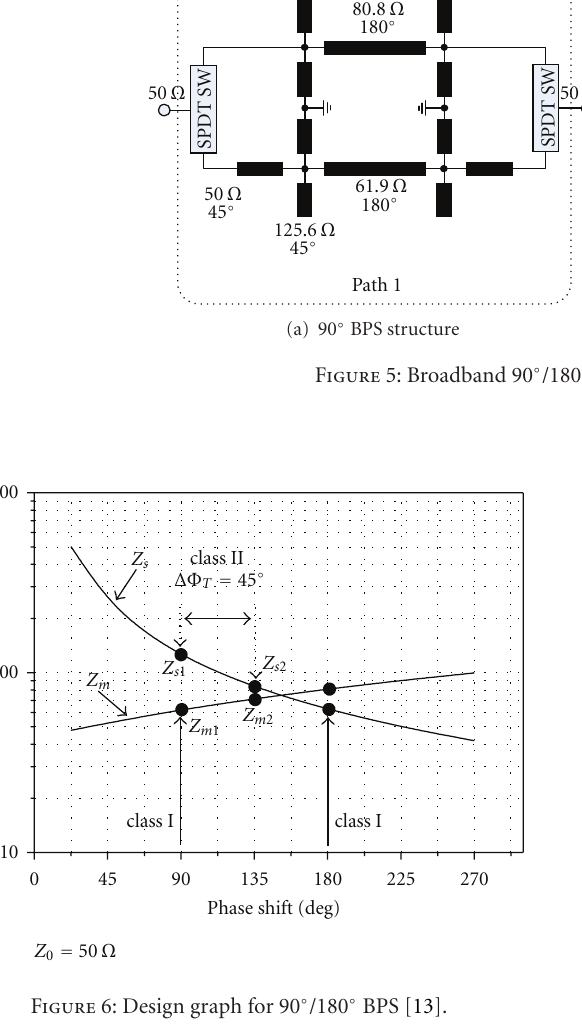
Figure 7: Fabricated BFN PR